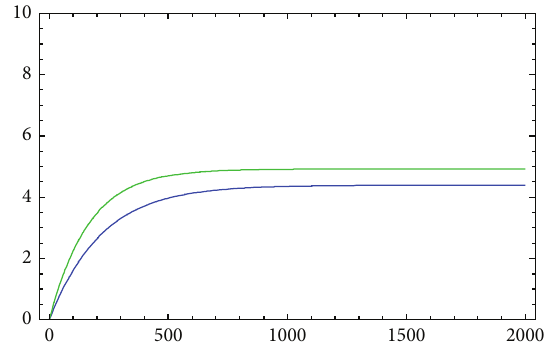
Figure 1: The graphs of 𝑦 3 (𝑡) (above) and 𝑦 1 (𝑡) (below) with the order 2𝛼